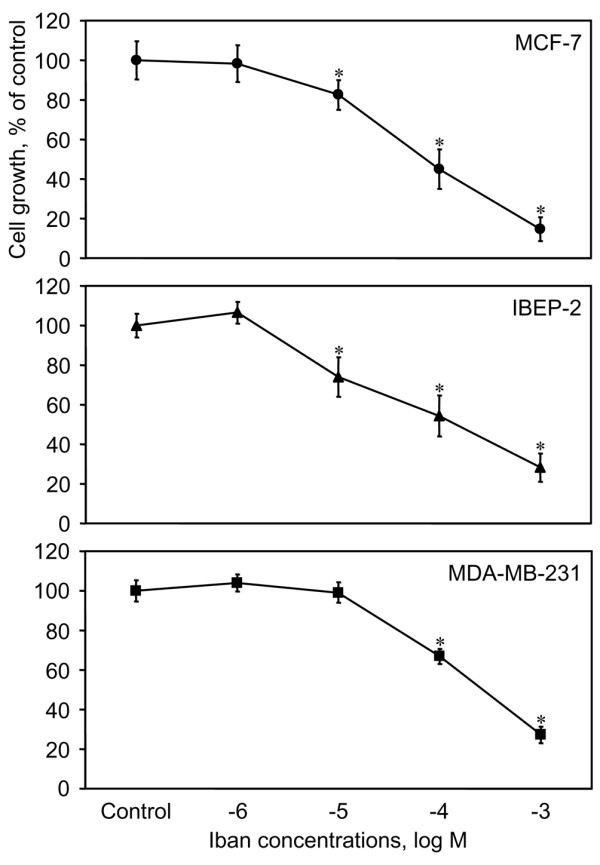
Dose-response analyses of ibandronate on MCF-7, IBEP-2 and MDA-MB-231 cells. Breast cancer cells were cultured for three days in steroid-free medium containing ibandronate (Iban) or vehicle (control). Cell proliferation was determined by crystal violet staining assay. Data are presented as percentages of control values (mean ± SD). Experiments were performed four times in replicate. Asterisks indicate ANOVA p < 0.01 versus control, Dunnett post hoc test.